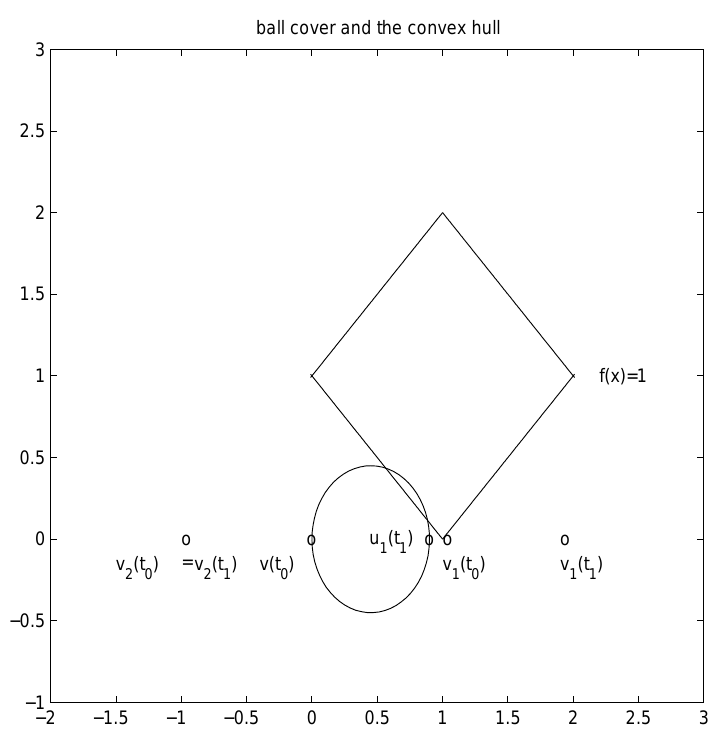
Figure 3. l ball cover requires 2